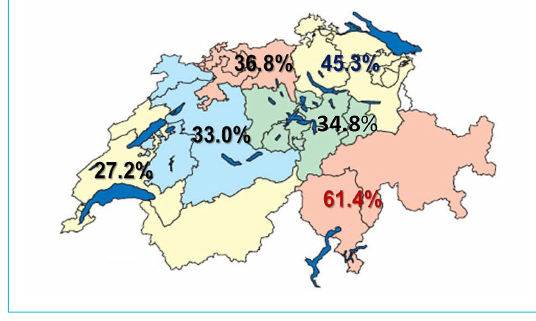
Figure 2: Distribution of anaesthesiologists with a non-Swiss med- ical degree (N = 872).